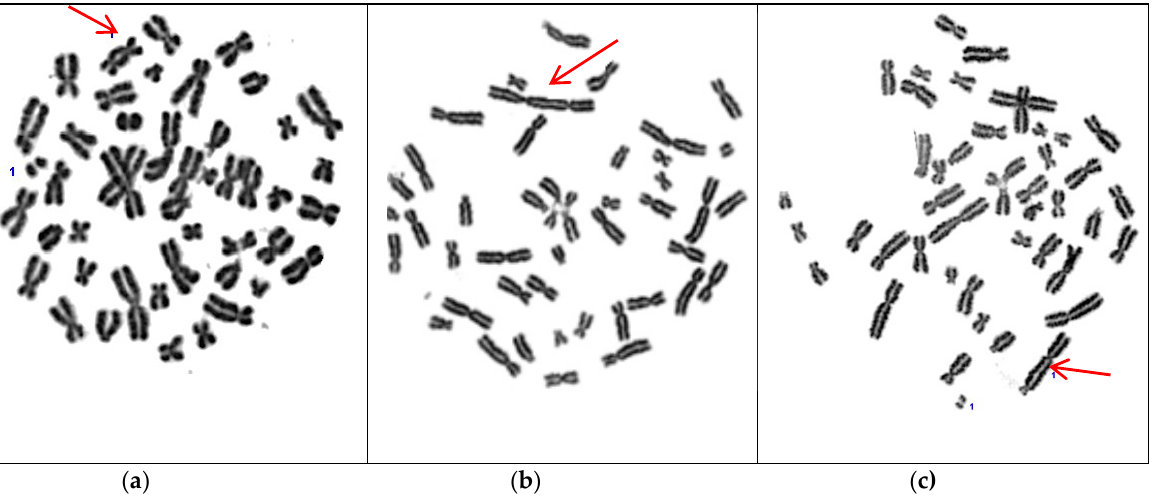
Figure 4. Representative examples of dicentric analysis at metaphase of peripheral blood lymphocytes, from a prostate cancer patient, irradiated using the ( a ) 3D-CRT, ( b ) IMRT, and ( c ) VMAT technique. The red arrows show the dicentric chromosomes .